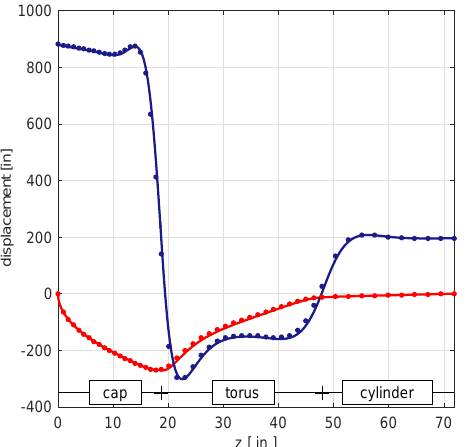
Figure 16. Torispherical tank subject to uniform internal pressure. Displacement components: u blue solid line - present approach vs. blue bullets - reference solution [53], w red solid line - present approach vs. red bullets - reference solution [59].